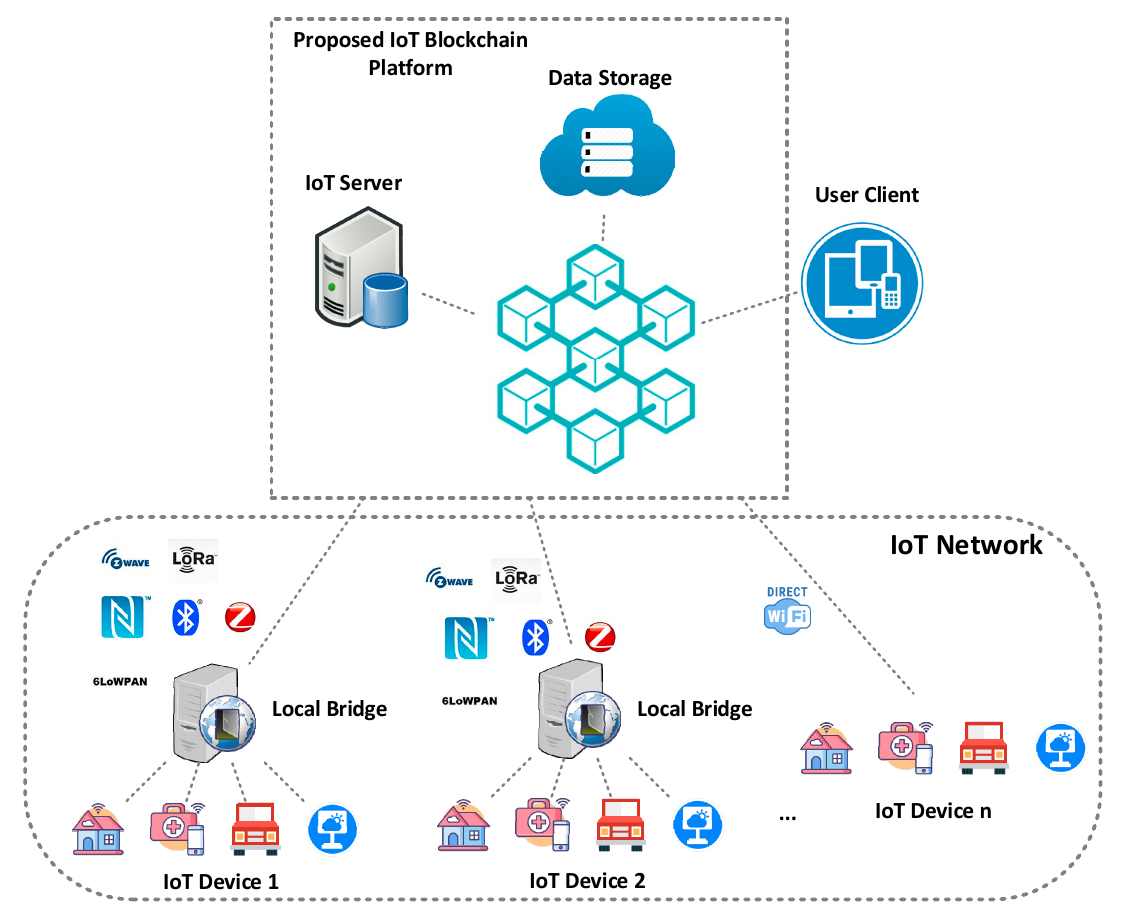
Figure 1. IoT blockchain platform conceptual scenario.